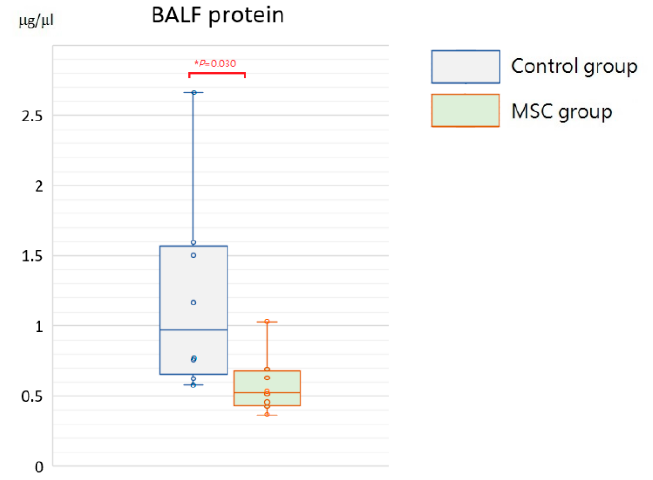
Figure 5. Boxplots of protein levels in the BALF at 48 h after LPS-induced ALI. Protein levels in the BALF were significantly higher in the control group. Each circle represents the concentration of each animal. n = 8 mice/group.